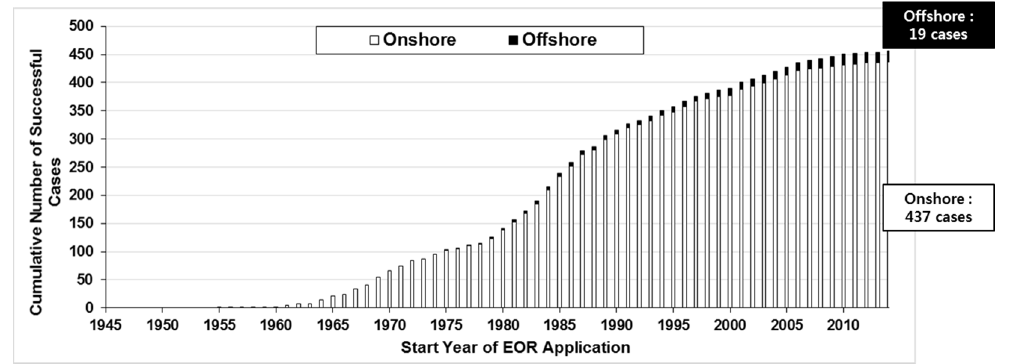
Figure 1. Cumulative number of successful cases of EOR application by start year [9–23].